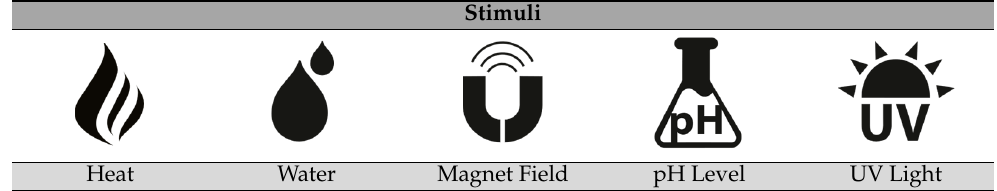
Table 4. The most preferred 4D Printing stimuli symbols.